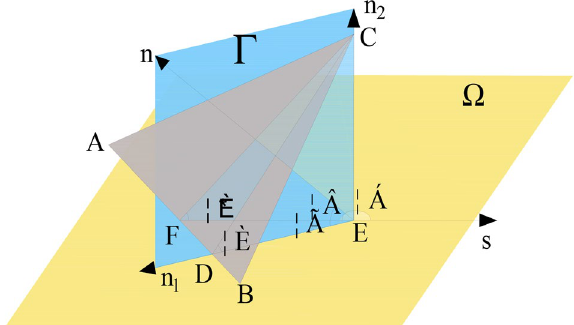
Figure 3. Calculation diagram.